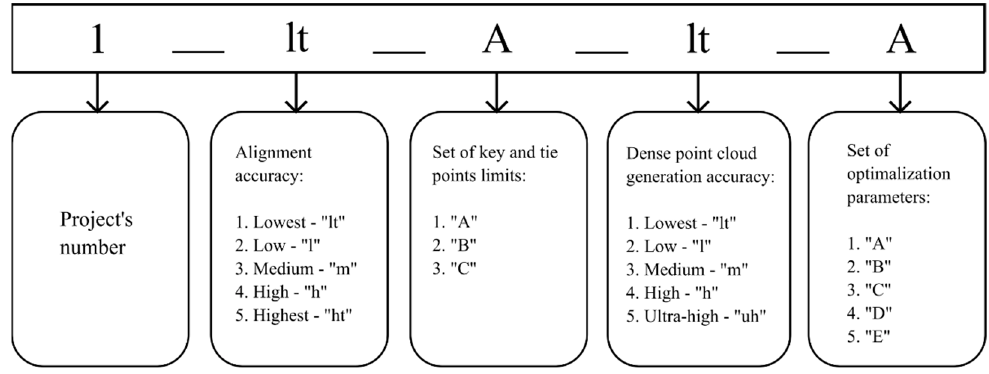
Figure 3. Scheme of project’s code naming.